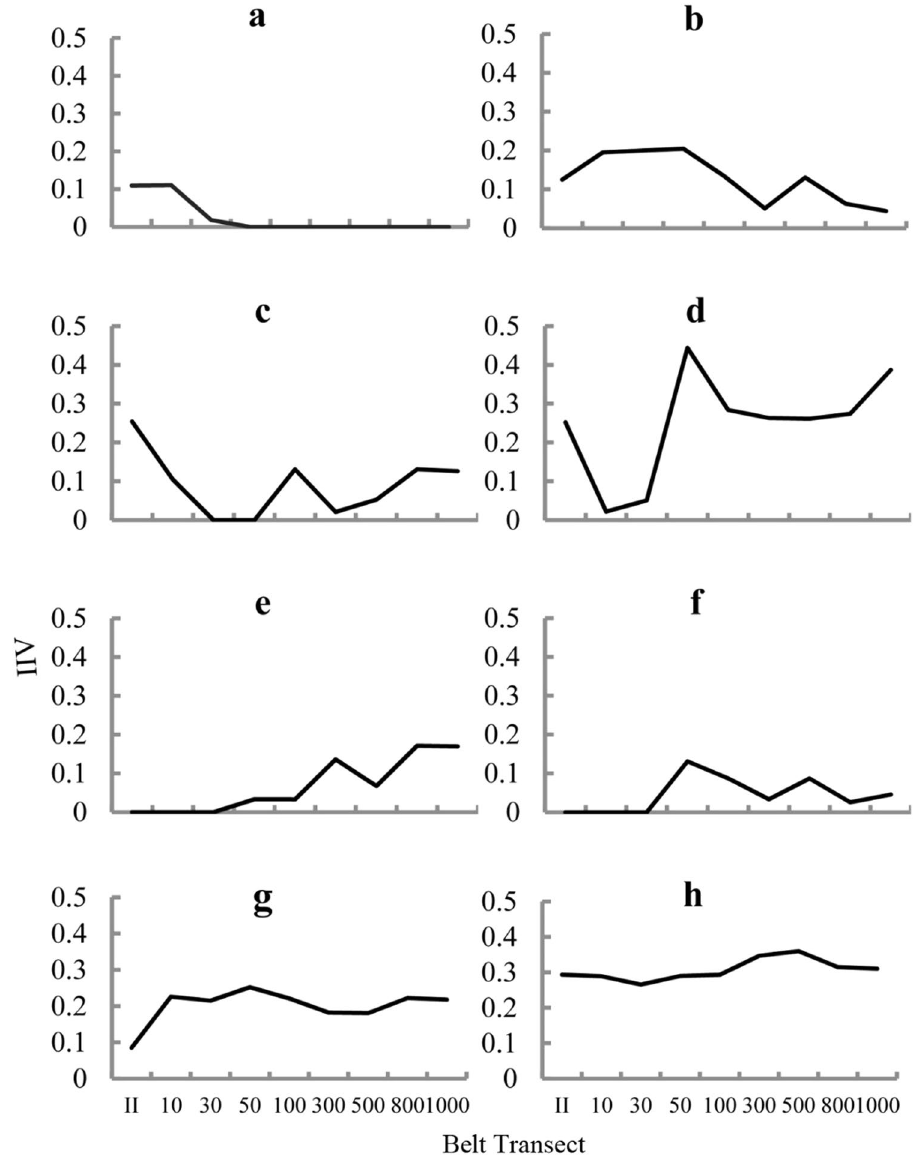
Figure 7. Analyses for the IIVs of the different groups of plants. Clusters a-c belonged in the G1. They were the group of species that was less affected near the construction. Clusters d-f were clustered in G2. They were dominant position in the original plant community but obviously affected by the construction. Clusters g-h were common in all the belt transect.